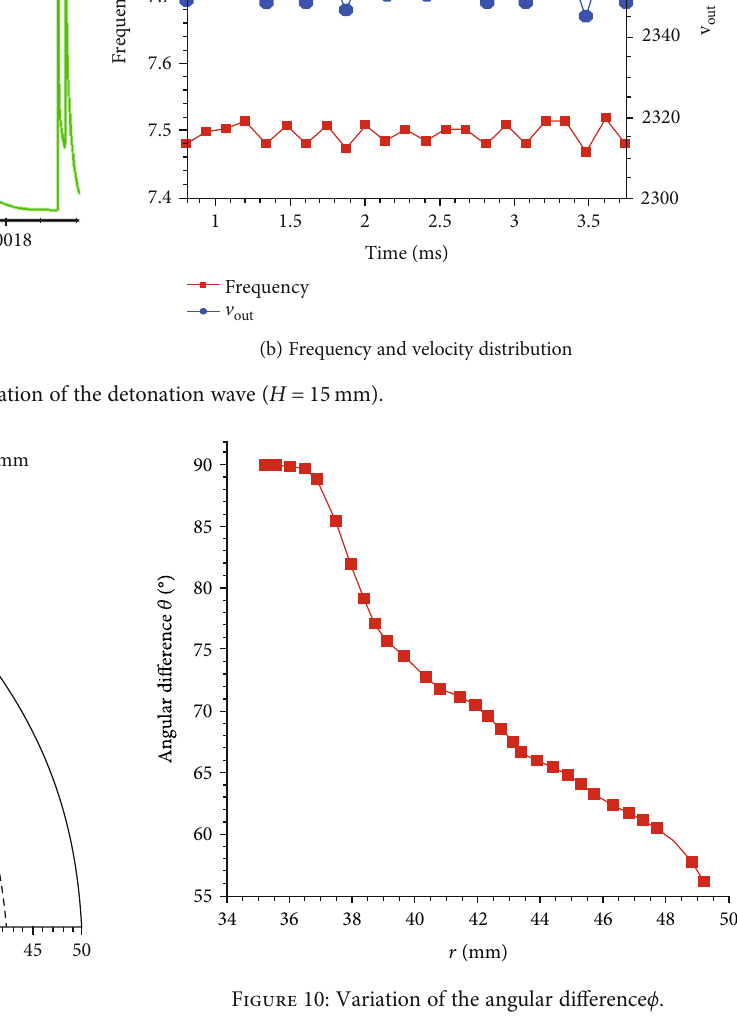
Figure 9: Sketch map of the normal velocity.